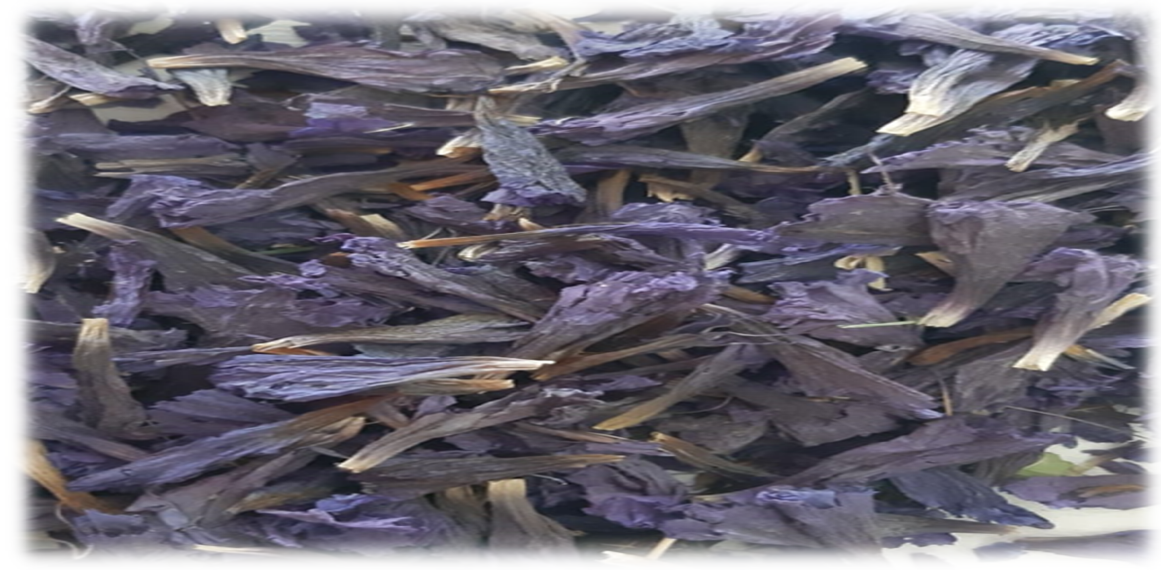
Figure 7. Photograph of the shade-dried borage ( Echium amoenum ) flowers.